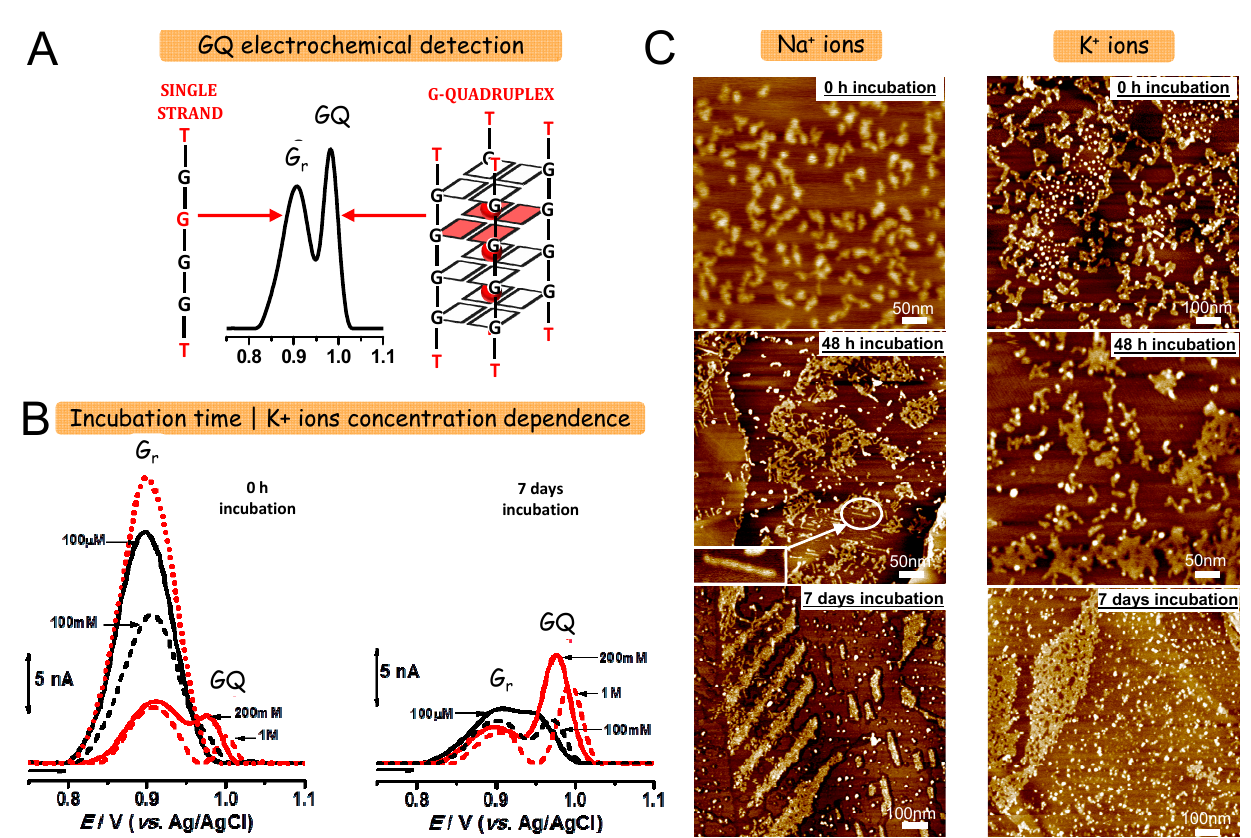
Figure 2. ( A ) Schematic representation of the d(TG 4 T) single-stranded and G-quadruplex (GQ) electrochemical detection. ( B ) Baseline-corrected DPV in 3.0 µM d(TG 4 T) at pH = 7.0, after 0 h and 7 days of incubation, in the absence of K + ions (red dotted line), and in the presence of different concentrations of K+ ions. ( C ) AFM images of d(TG 4 T) spontaneously adsorbed onto highly oriented pyrolytic graphite (HOPG) from 0.3 µM d(TG 4 T) at pH = 7.0, after different incubation times. Adapted from [55] with permission.